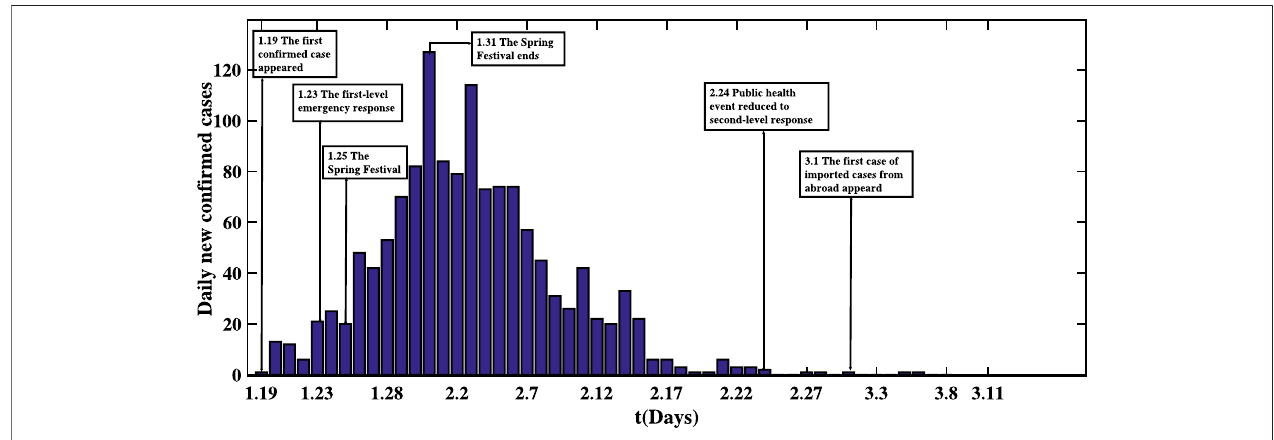
FIGURE 1 | Transmission scheme of COVID-19 in Guangdong Province. Guangdong Province launched the fi rst-level response to major health incidents on January 23 and the Spring Festival ends on January 31.